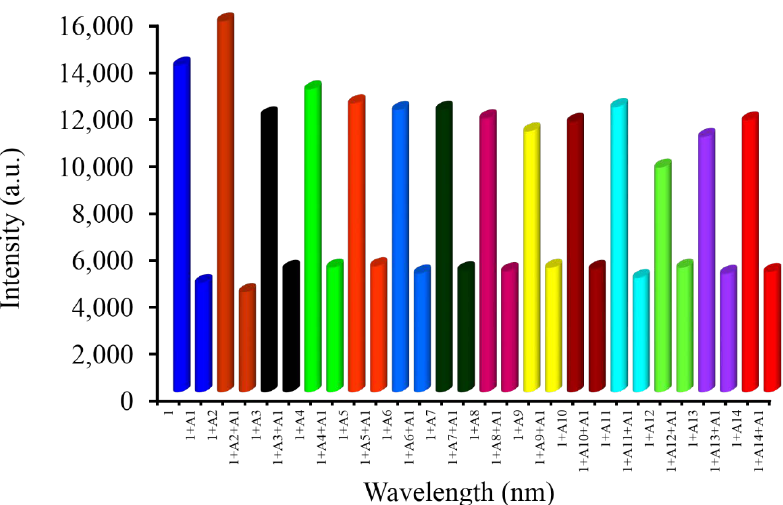
Figure 8. Competitive fluorescence study (λ ex = 365 nm) between receptor 1 (1.0 × 10 − 5 M) and A1 (2 equivalents) in the presence of different nitroaromatics (2 equivalents).